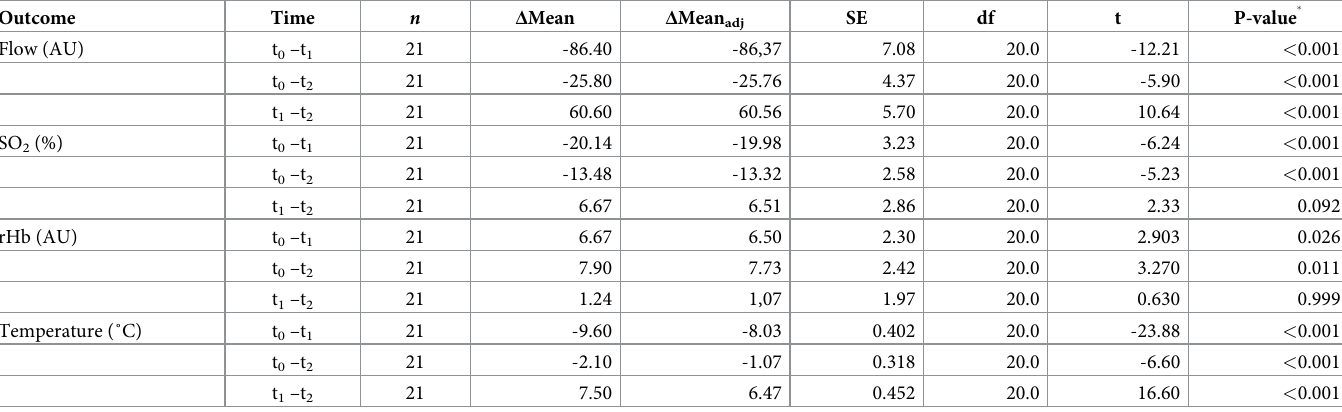
Table 3. Pairwise comparisons and adjustment for regression to the